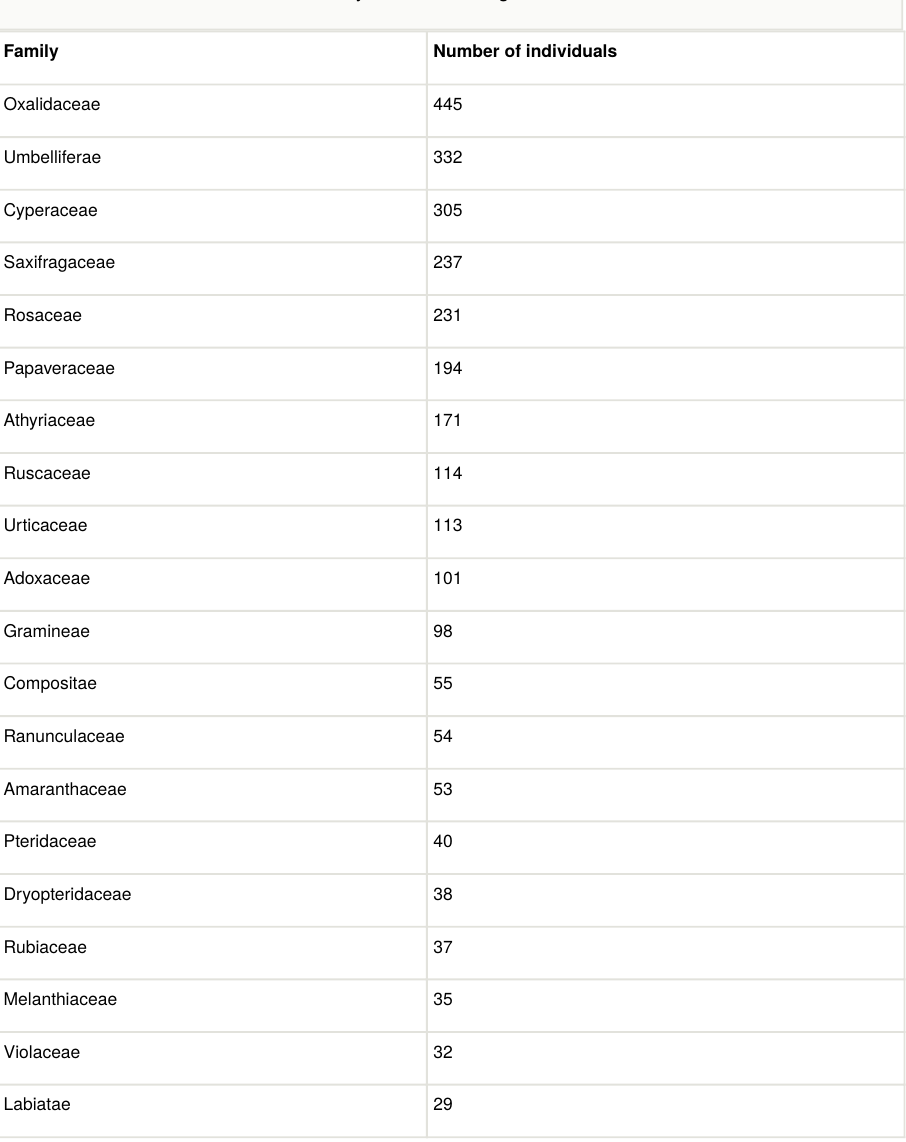
The number of individuals in each family of herb in Liangshui National